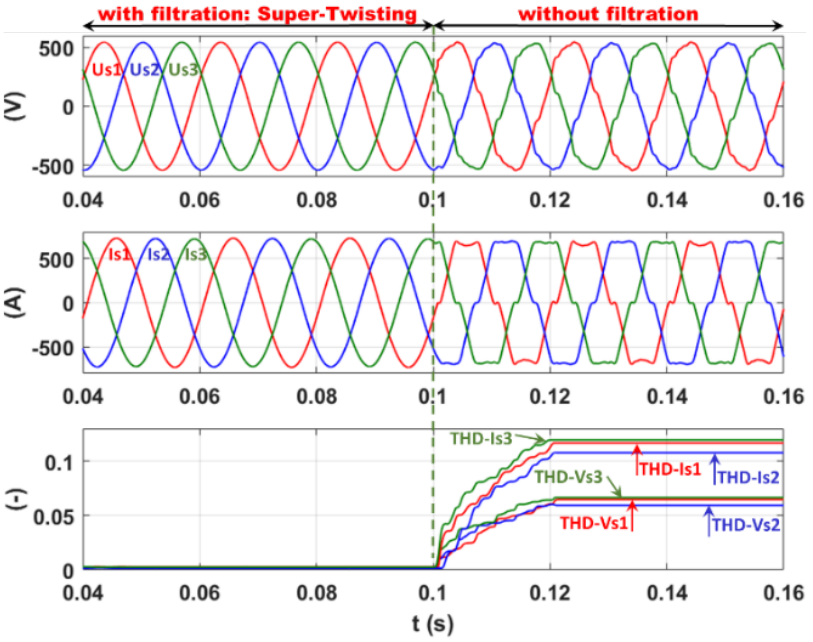
Figure 21. Current filtration: 2-SMC Super-Twisting controller.